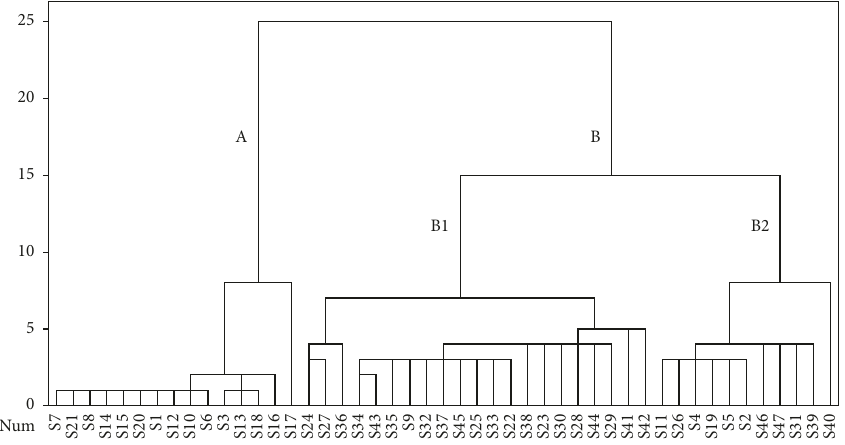
Figure 8: Hierarchical CA of 47 batches of Acacia catechu